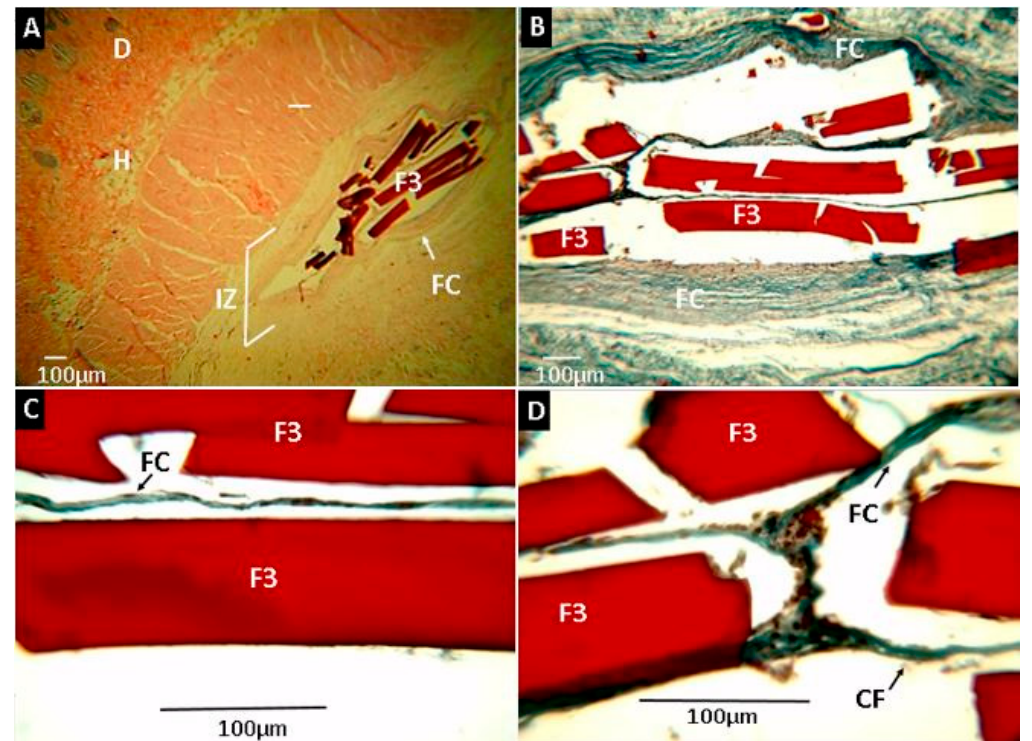
Figure 13. Histological analysis of experimental sample F3 (CS:PVA:ox-CNO 29.00:70.00:1.00). Magnifications are as follows: ( A ) 4 × H&E, ( B ) 10 × H&E, ( C ) 40 × MT, ( D ) 100 × MT. D: dermis. H: